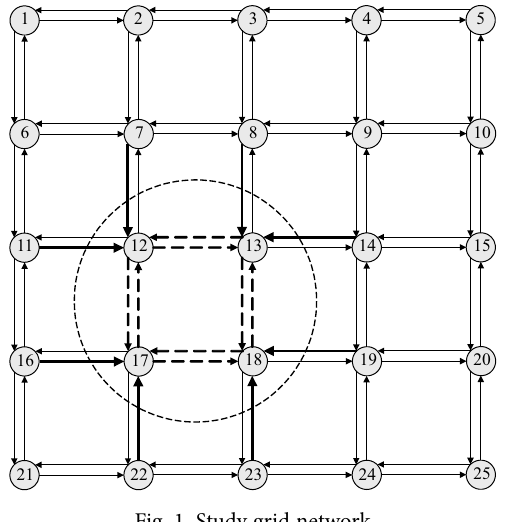
Fig. 1. Study grid